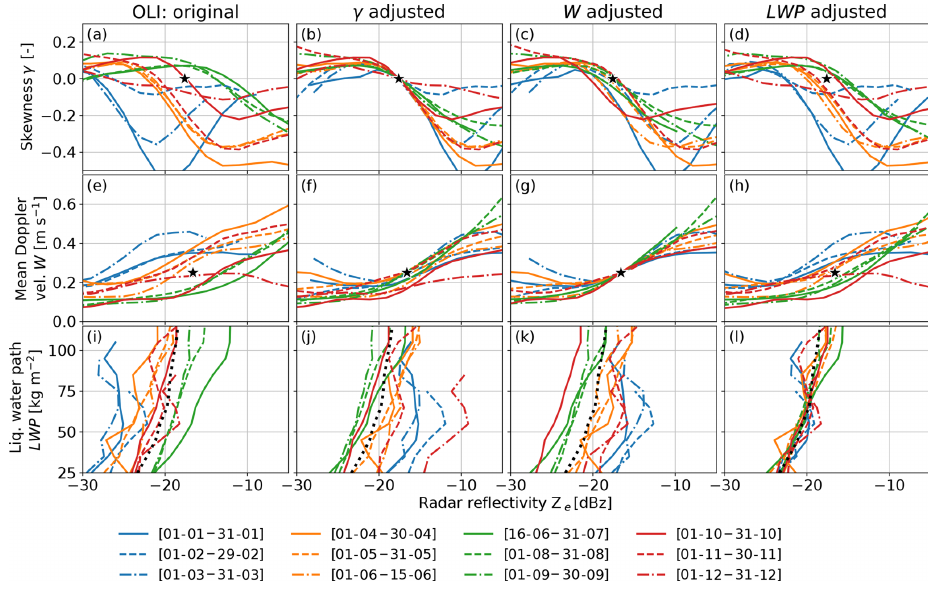
Figure 6. As in Fig. 5 but for Oliktok Point